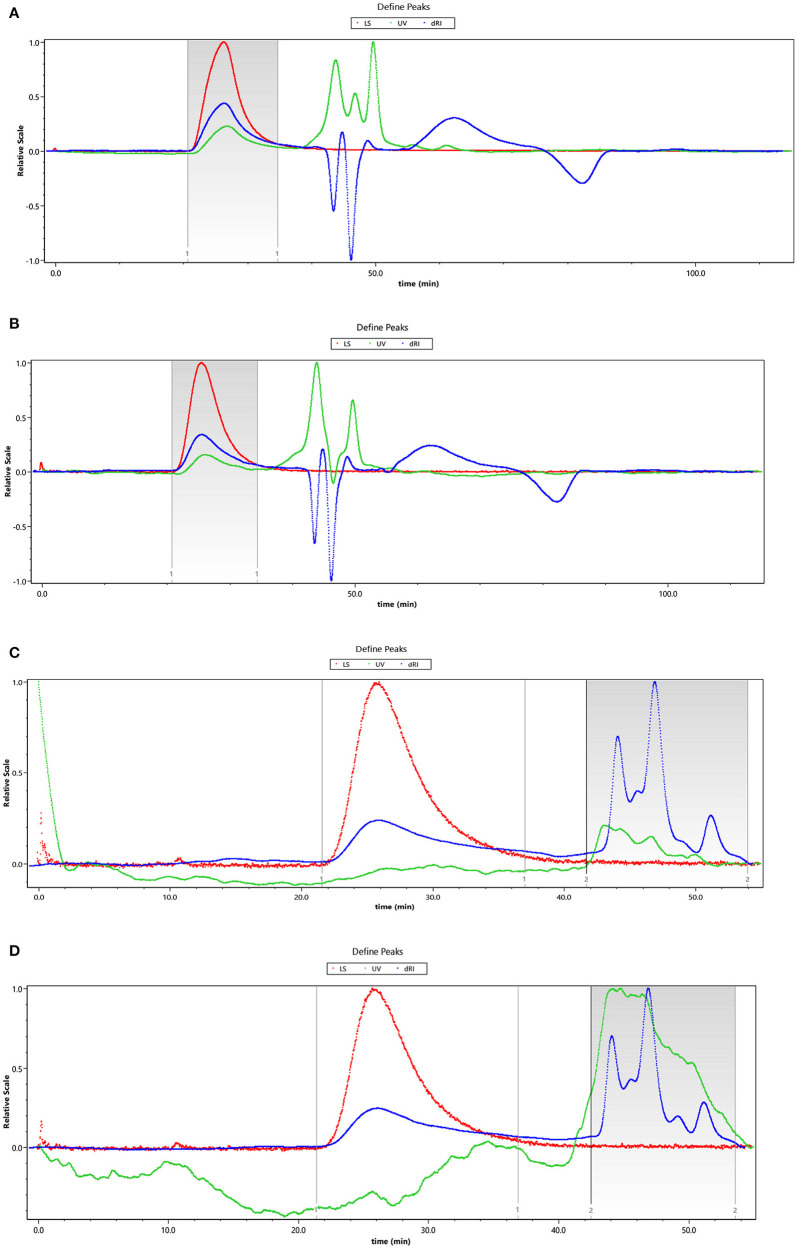
The HPSEC chromatogram of HEBG (A), HEBG-1 (B), HEBG-2 (C), and HEBG-3 (D).